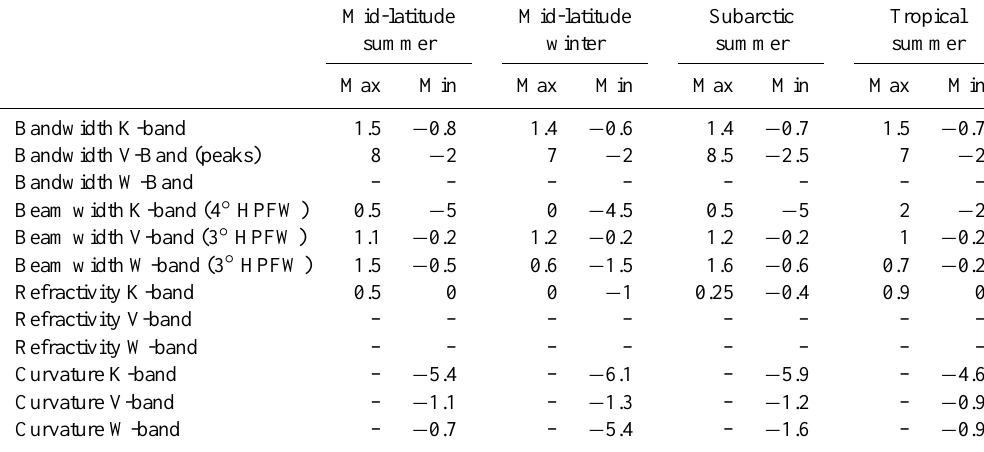
Table 3. Summary of the range of biases in clear air for elevation angles above 4 ◦ in TB (in K) associated to each effect (bandwidth (100– 1000MHz), beam width (0.5–10 ◦ ), refractivity, and Earth curvature) for each set of frequencies and each sounding. Entries with long dashes represent values that are below any instrument measurement